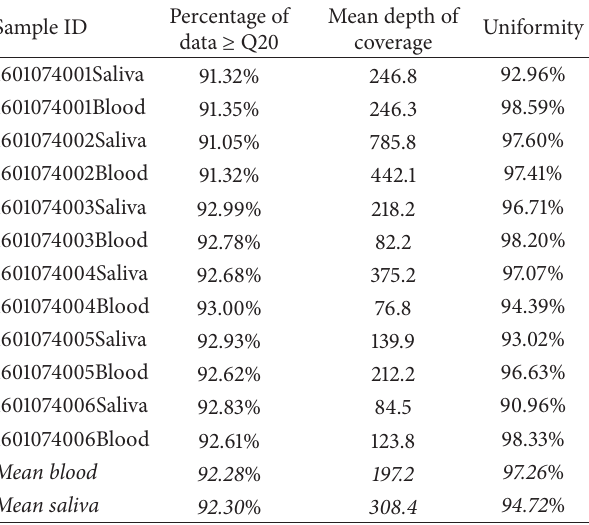
Table 2: Quality score, mean depth coverage, and uniformity of the data generated from DNA samples extracted from saliva and their matched blood